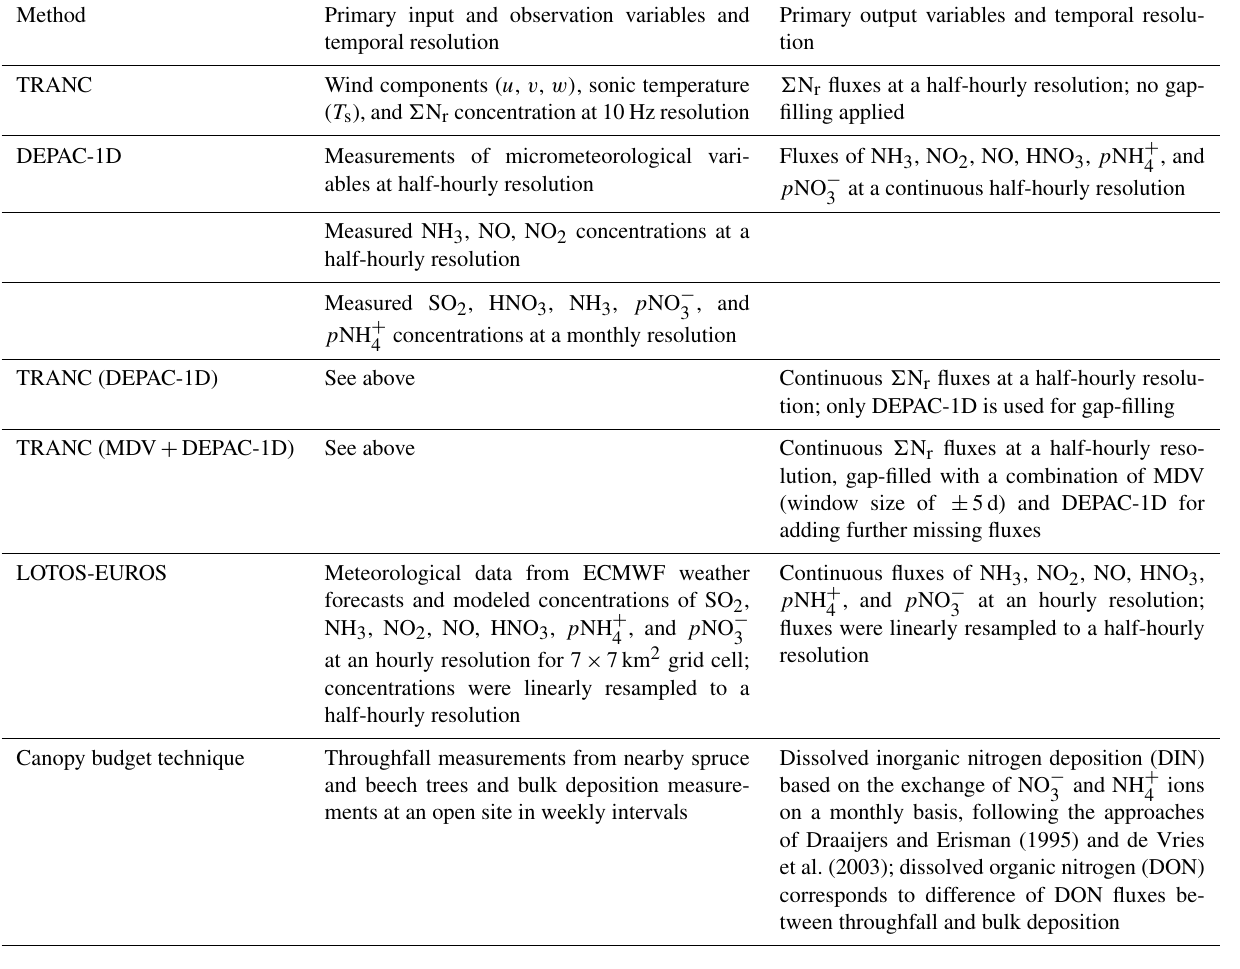
Table 1. Overview of methods used for estimating (cid:54) N r dry